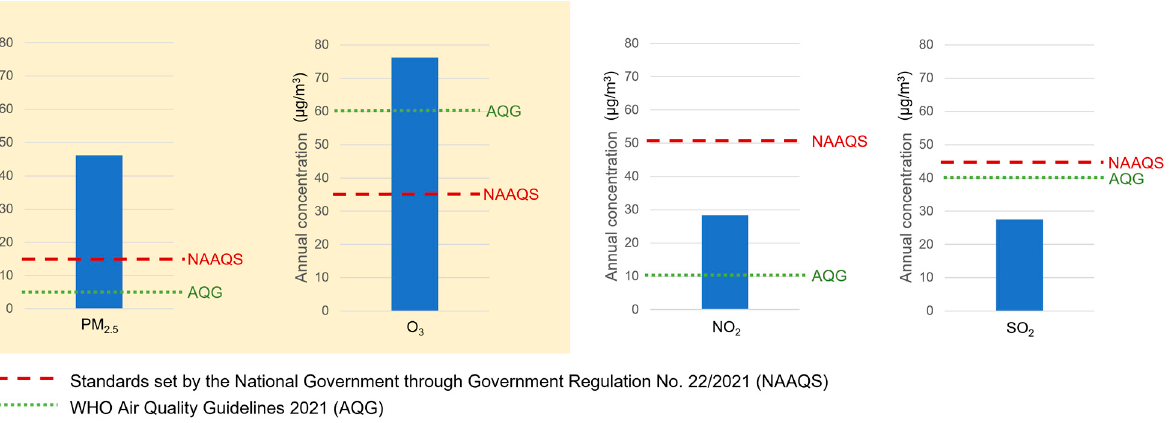
Figure 3. Air pollutants were prioritized based on exceedances of the National Ambient Air Quality Standards [32] and the World Health Organization's Air Quality Guidelines 2021 [33]. Air pollutants of interest are highlighted in